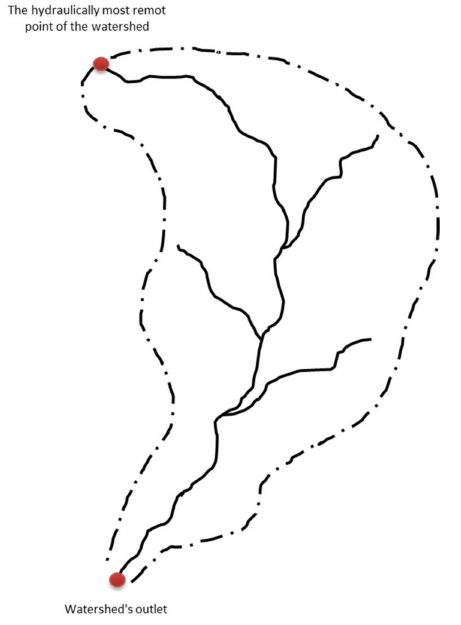
Figure 1. Schematic of a watershed to illustrate definition of Tc (definition i).